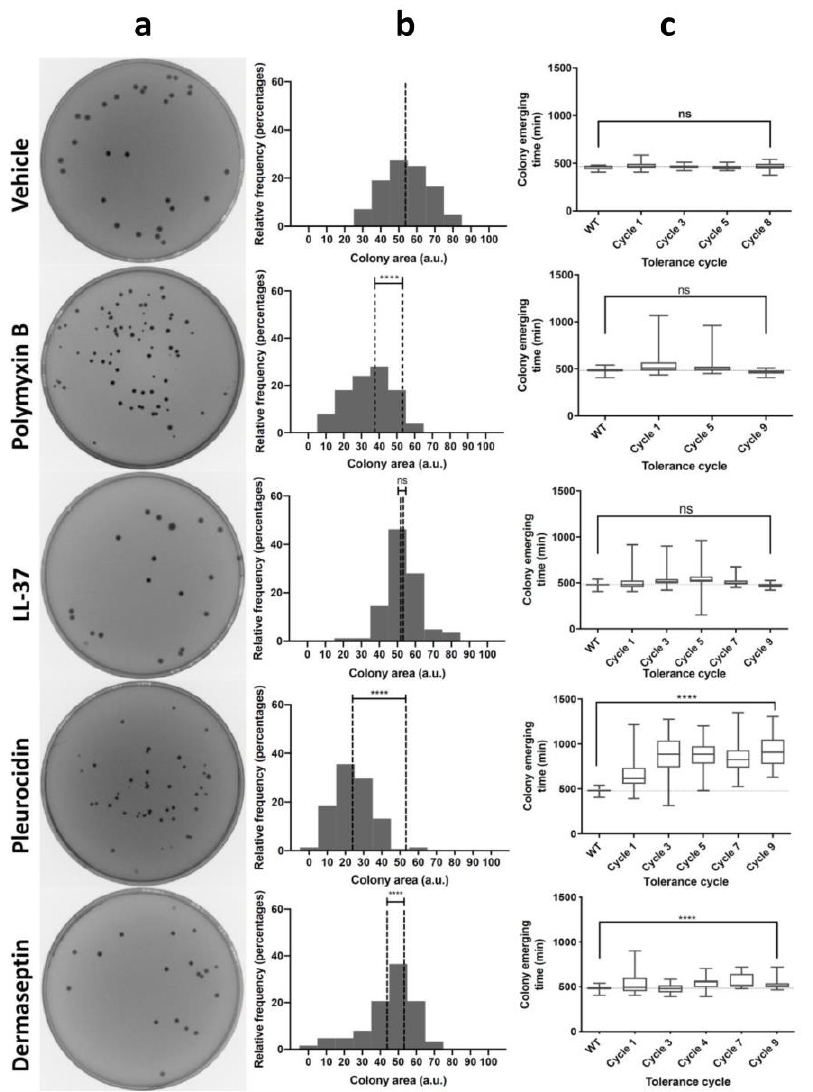
Figure 2. Development of tolerance after AMP treatment. ( a ) Plate images before and after the first treatment of bacteria with AMPs. ( b ) Colony area distribution (accumulated in 3 replicates) is shown beside the image plates. Treated and reference means are displayed as dotted lines. ( c ) Col- ony appearance times as measured with ScanLag vs. the different AMPs. The vehicle control is displayed for comparison. All experiments were done in triplicate. p -values are reported as indi- cated: ns : non-significant; **** p < 0.001.